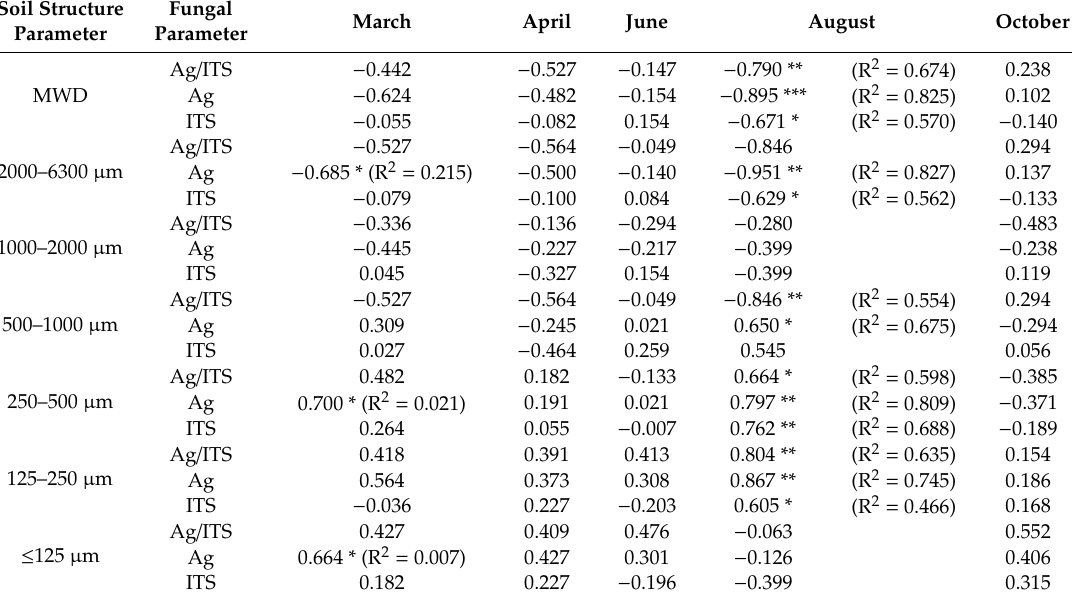
Table 3. Correlation coe ffi cients and regression coe ffi cients (R 2 ) between soil fungal parameters and MWD and mass distributions of sieve-size